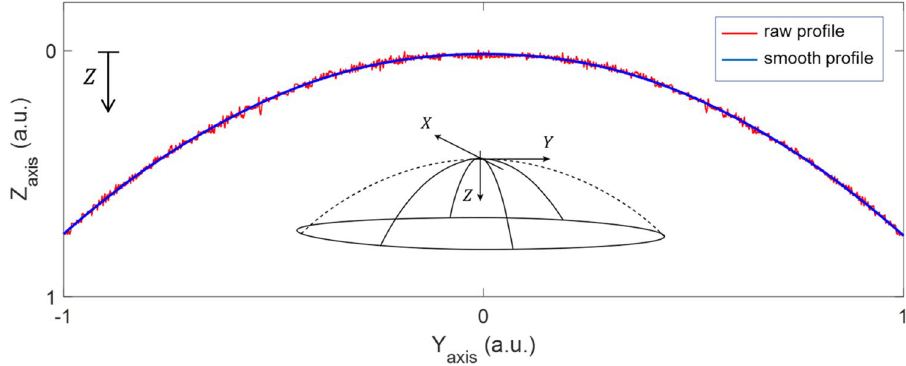
Figure 1. Example of a schematic raw profile and the corresponding smoothed profile obtained for an intraocular lens surface. Axes expressed in arbitrary units (a.u.).